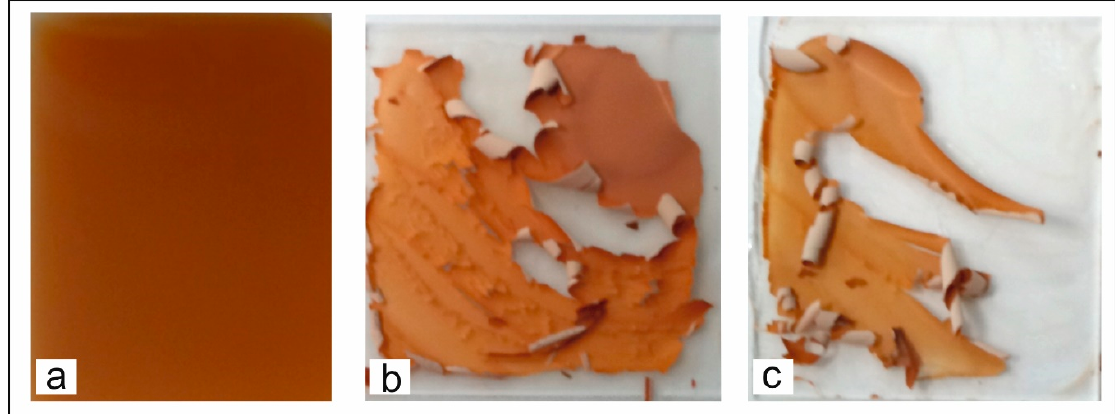
Figure 25. Demonstration of shrinkage behavior of clay fraction of LM1 sample, ( a ) after a cycle of water saturation and ( b , c ) consequence drying at room temperature, due to participation of swelling minerals of smectite and mixed–layer illite/smectite.